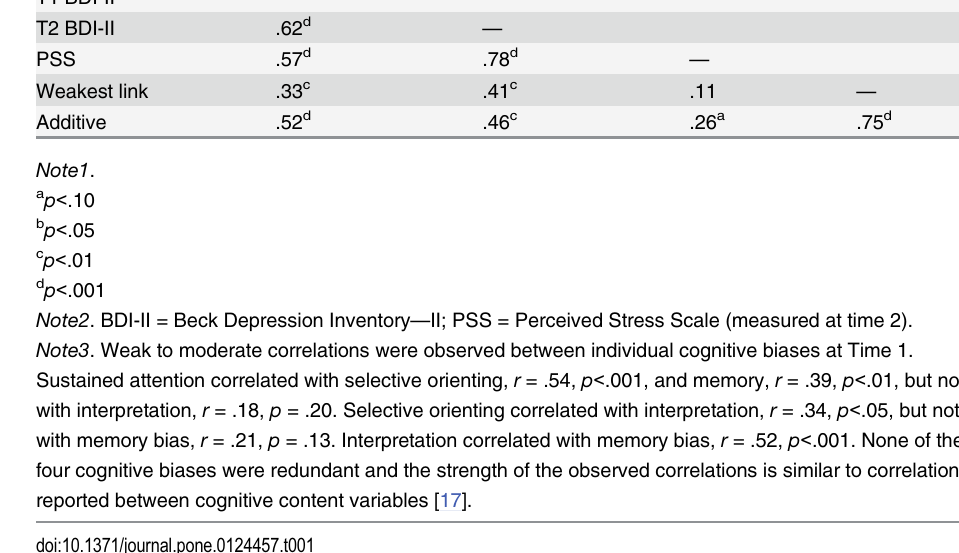
Table 1. Correlations between depressive symptom severity, perceived stress and cognitive bias composites.